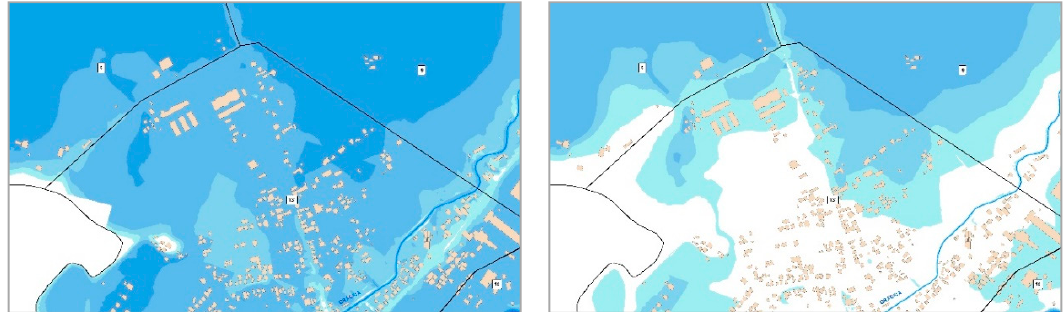
Figure 8. Water depths due to 200-year flood event in downtown Ub, including part of sectors 8, 9, 12, and 13 ′ , under existing flood protection measures ( left panel) and under green scenario ( right panel).